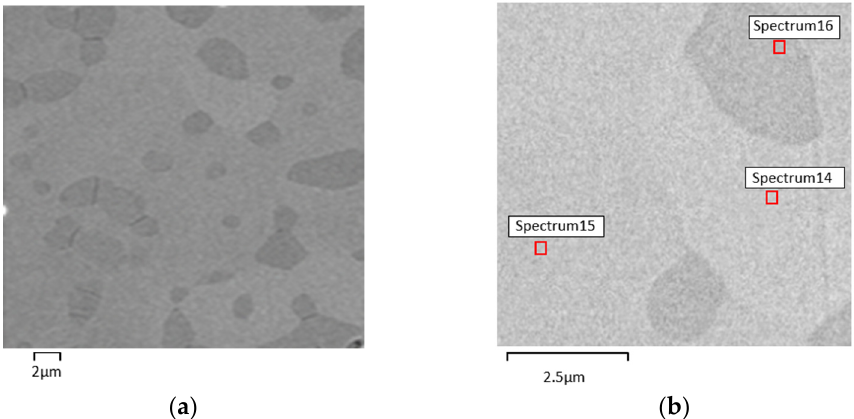
Figure 7. X-ray diffractograms of 3D object from filament B. ( a ) top, ( b ) bottom. The micrographies of 3D objects from composition C (NiTi + 5 wt.% TiH 2 ) show a